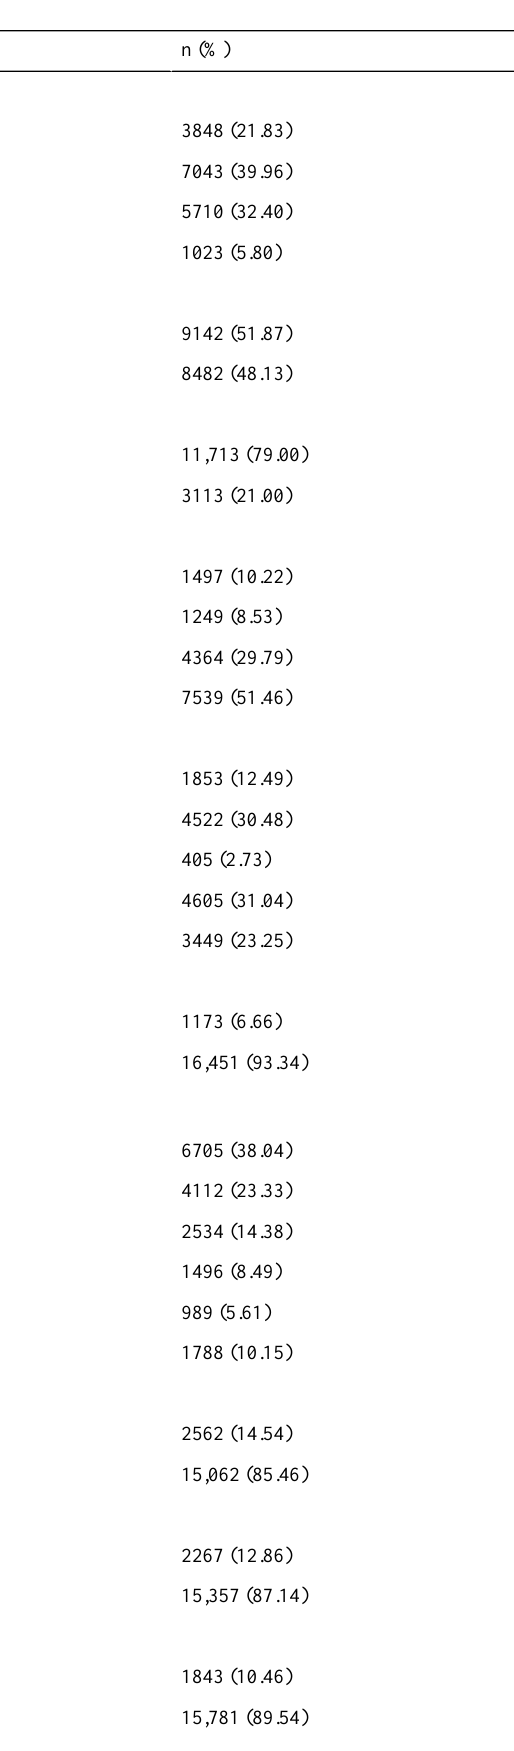
Table 2. Baseline characteristics